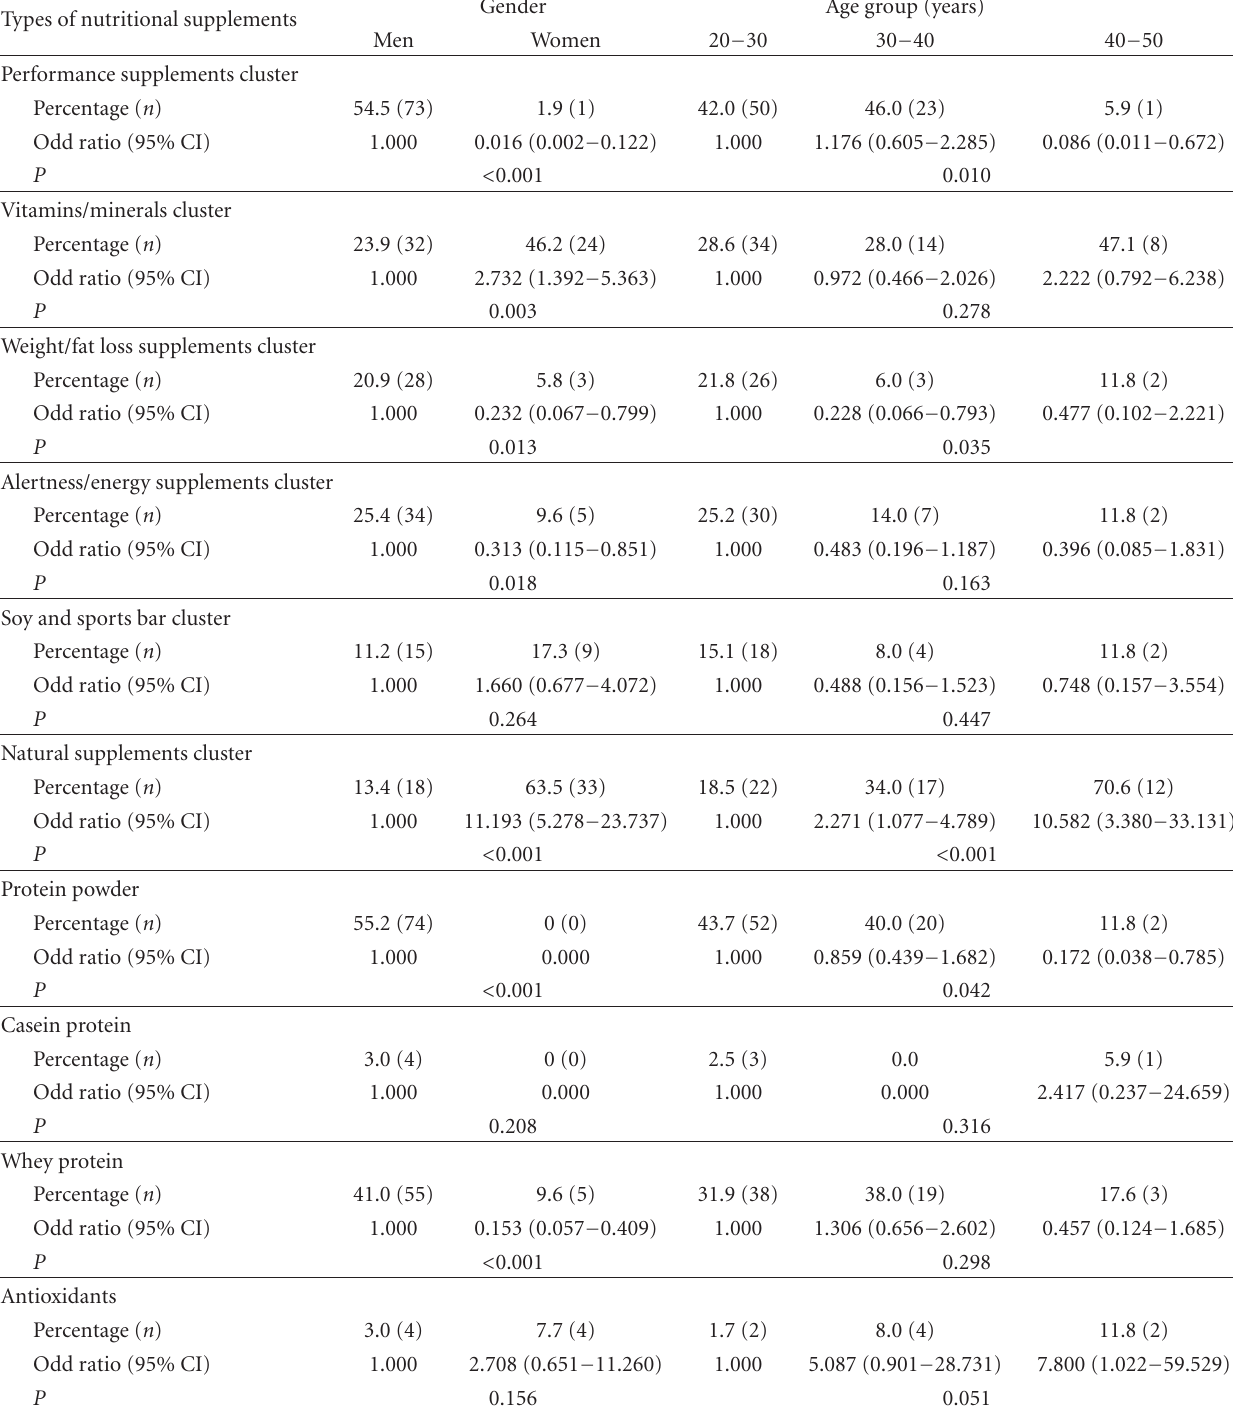
Table 3: Types of nutritional supplements by gender and age group ( n = 186). CI: confidence interval. No missing